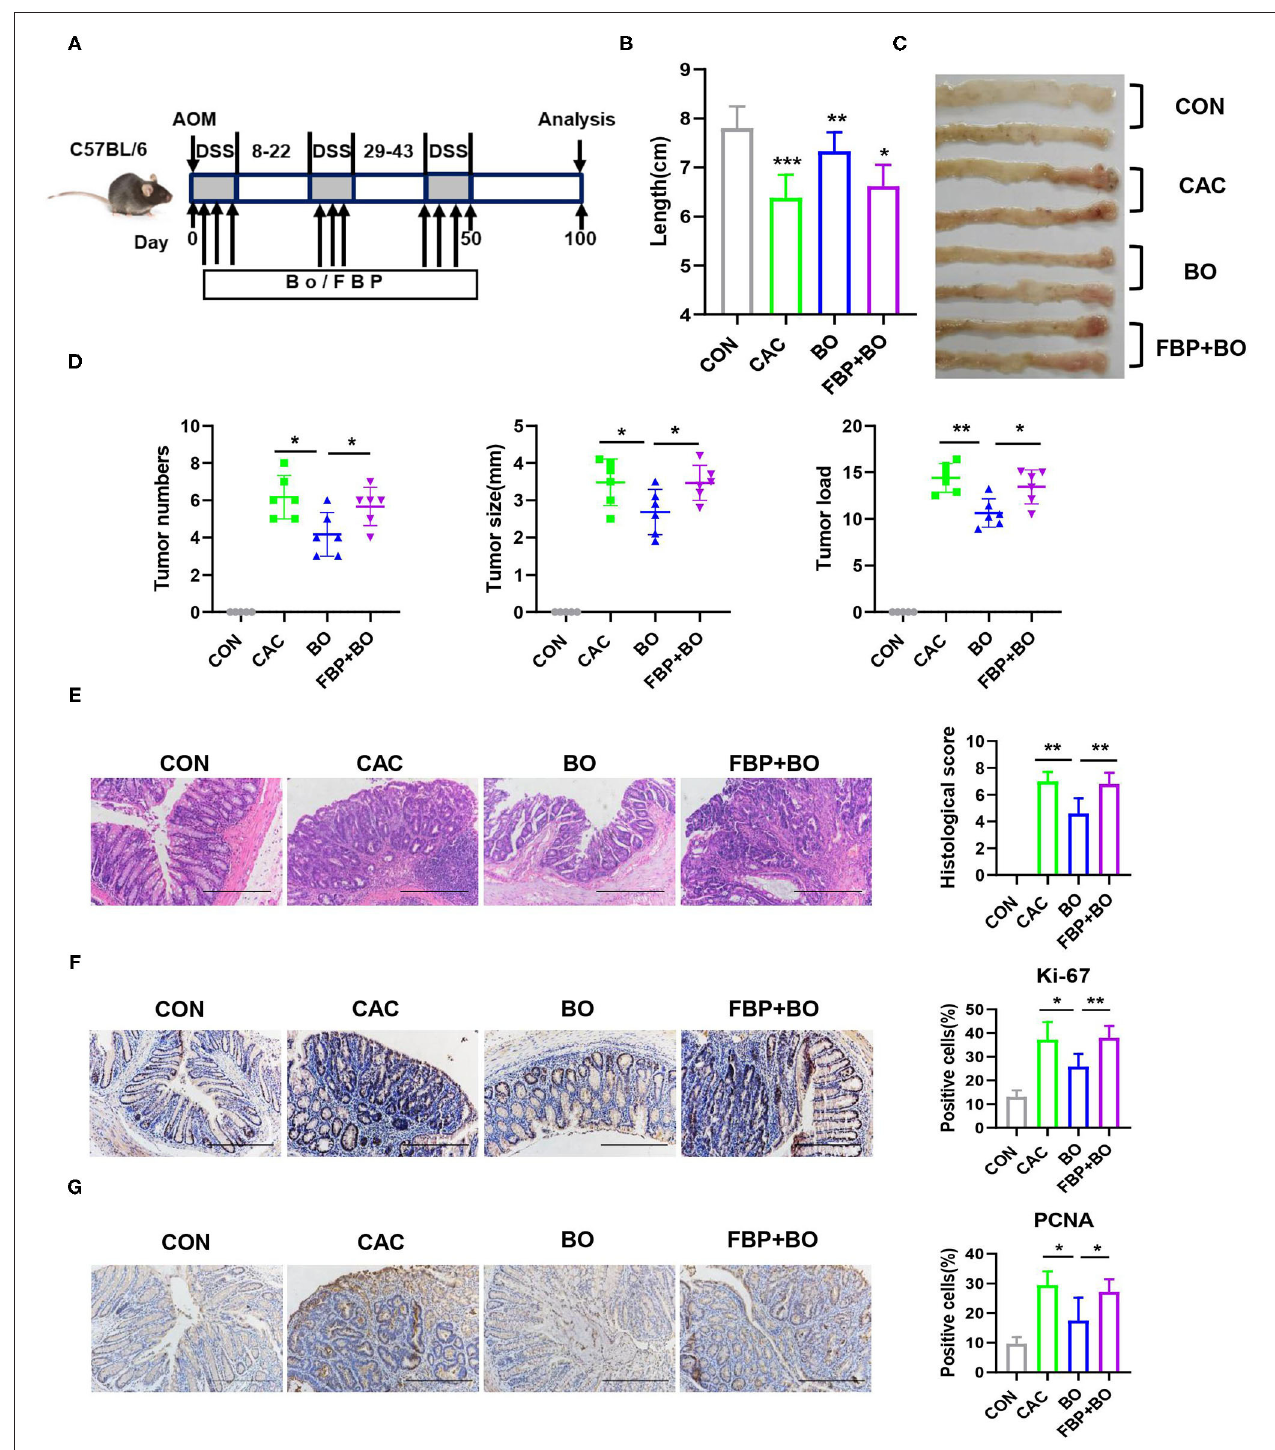
FIGURE 5 | Bornlisy inhibits colon cancer cell proliferation by reducing glycolysis. (A) The C57BL/6J mice ( n = 5 for each group) were intraperitoneally treated with fructose-2,6-biphosphate (FBP) (500 mg/kg, once every 2 days) and orally treated with BO (10 ml/kg, once every 2 days) during AOM-DSS administration. After induction of tumorigenesis (100 days), the mice were euthanized and the colons were removed. (B) The representative images of colons were shown, and the colons’ lengths were measured. (C) The representative images of colon tumors were shown. (D) Tumor number, tumor size, and tumor load in colons were measured. (E) The histological colon tumor images using H&E staining were shown. The histological score was assessed by a pathologist (scale bars, 500 µ m). (F,G) The tumor tissues were stained for Ki-67 and PCNA (scale bar: 500 µ m). The percentages of Ki-67-positive and PCNA-positive cells were quantified. Data with error bars are represented as mean ± SD. Each panel is a representative experiment of at least three independent biological replicates. Scale bars, 50mm. * p < 0.05, ** p < 0.01, and *** p < 0.001 as determined by unpaired Student’s t -test.